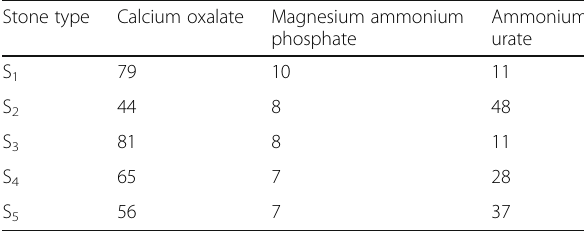
Table 2 Results of the analysis of compounds in the 5 types of PCNL stone (in